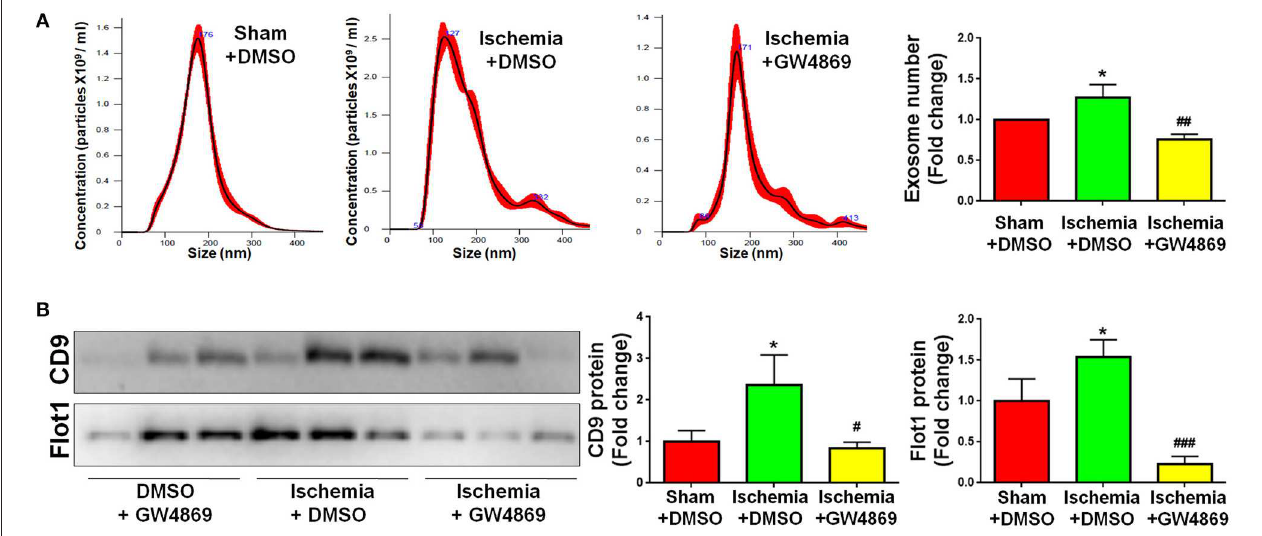
FIGURE 6 | GW4869 administration inhibits exosome release. Seven days post either DMSO or GW4869 administration, exosomes were collected from ischemic and sham brain extracellular spaces for NTA (A) and western blot (B) analyses. (A) The concentration of exosome suspension was determined by NTA. (B) Representative immunoblots of CD9 and Flot1 were shown along with quantifications of protein expression levels. Western blot data were presented as fold change compared with those in sham rat brains. Error bars denote s.d. from triplicate measurements. * p < 0.05 by two-tailed t -test ( n = 9). # p < 0.05, ## p < 0.01, and ### p < 0.001 vs. the ischemia with DMSO treatment group by two-tailed t -test ( n =